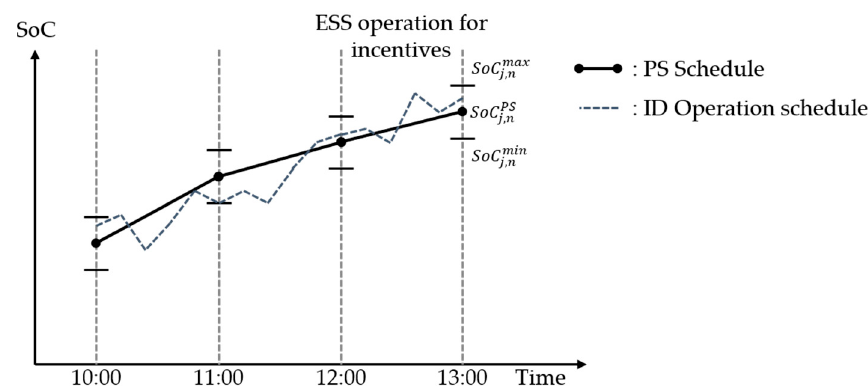
Figure 4. Change in SoC during ID operation and the PS schedule for each hour. The SMP and REC revenue are maximized by following the PS schedule hourly SoC, while incentives are maximized through free intra-hour charging.